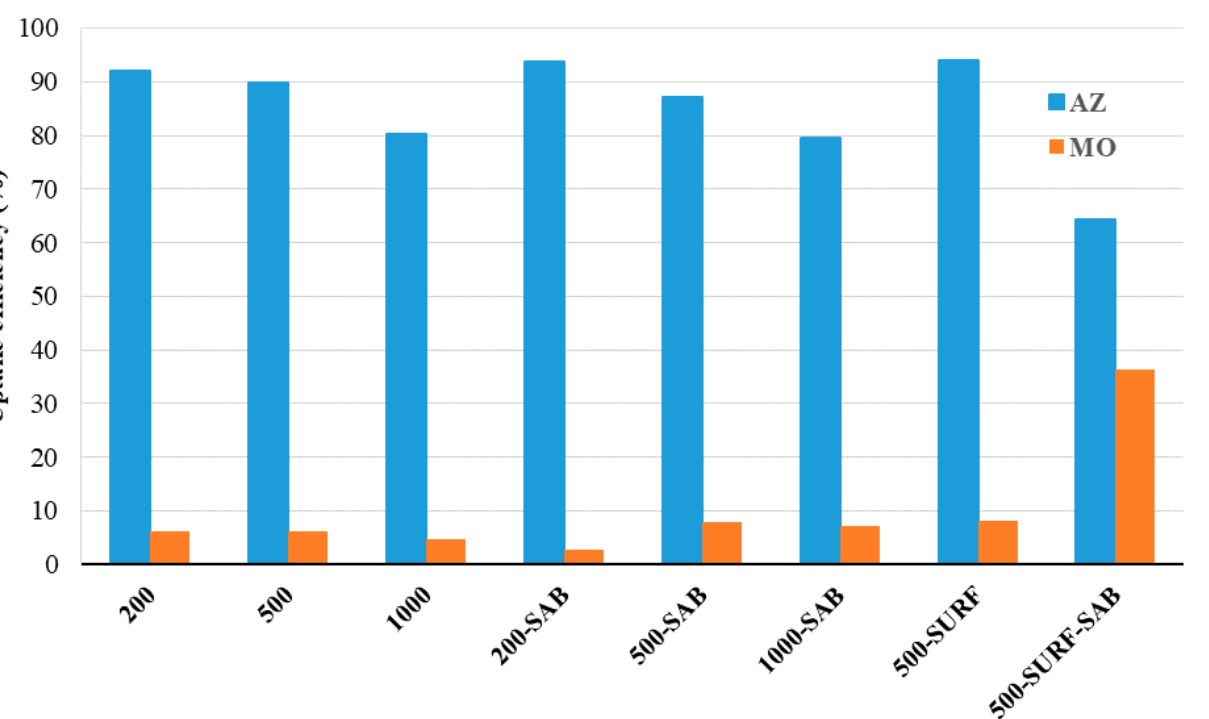
Figure 7. AZ and MO uptake efficiency of the prepared membranes at equilibrium using a batch technique under static conditions (the dye initial concentration was 0.01 mM and the material amount was 1% wt/vol with respect to the dye solution).